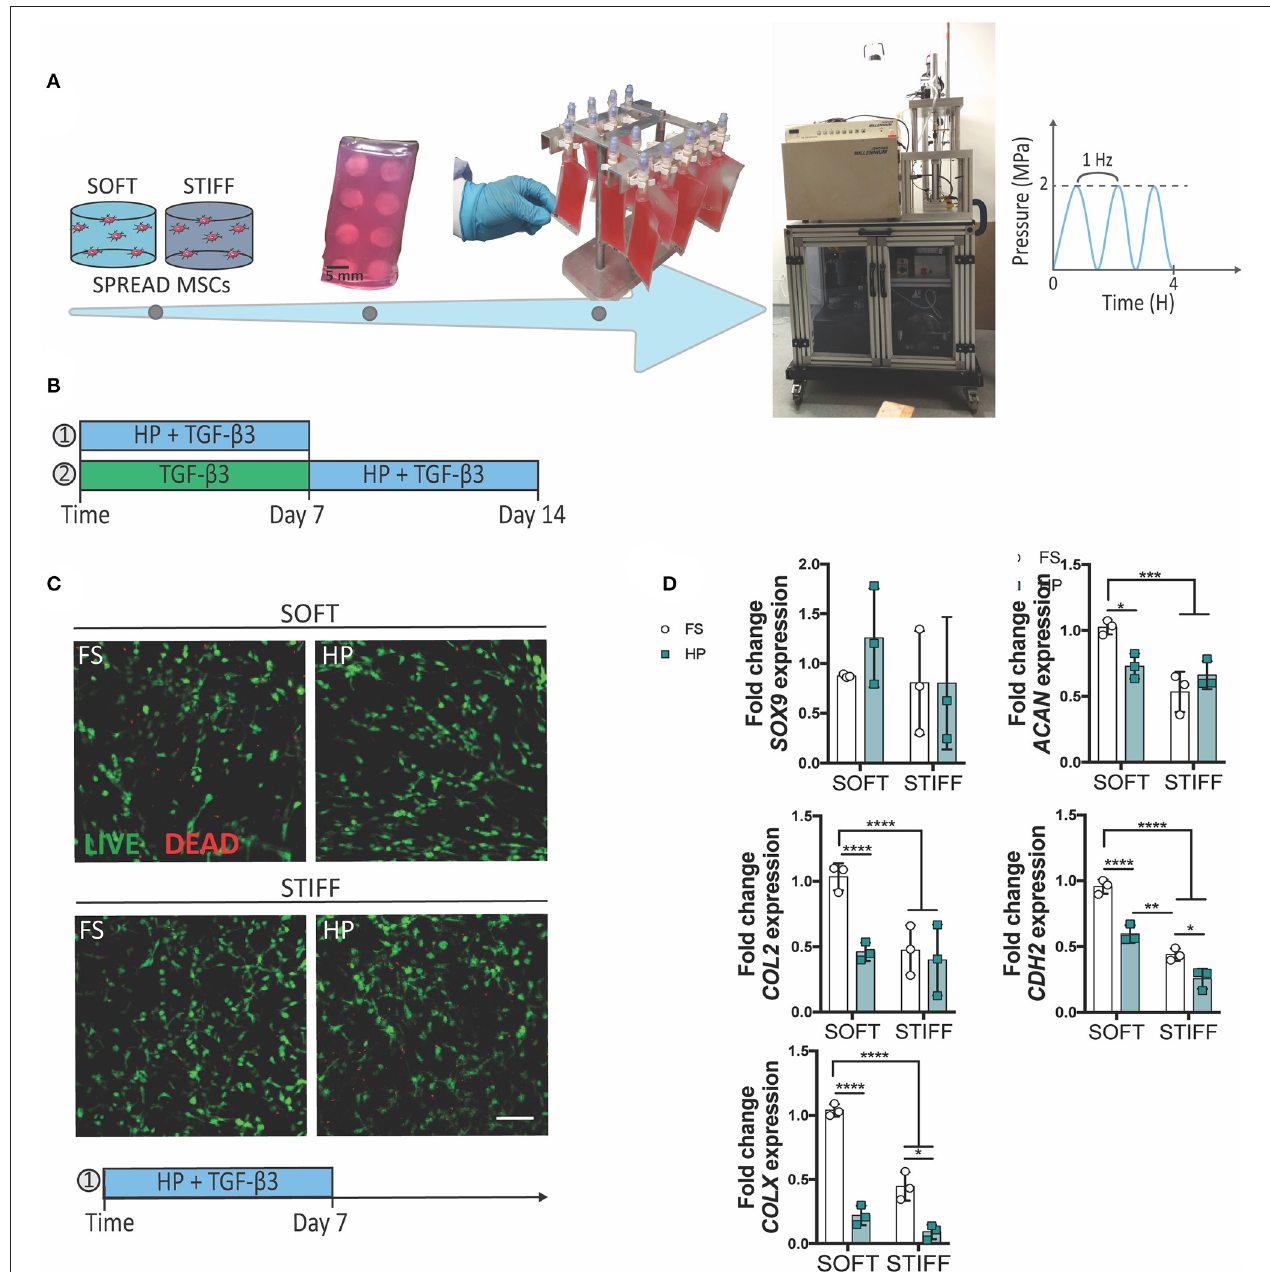
FIGURE 1 | The inhibitory effect of early HP stimulation on chondrogenesis of MSCs. Schematics depicting (A) the sample preparation procedure and (B) the experimental design. (C) Qualitative analysis of MSC viability after 7 days of dynamic culture. Live cells stained in green, dead cells in red. Scale bar 100 µ m. (D) Chondrogenic gene expression levels relative to the SOFT FS group. MSCs were cultured for 7 days in presence of chondrogenic factors and HP stimulation. FS, Free Swelling group; HP, Hydrostatic Pressure group. * p < 0.05, ** p < 0.01, *** p < 0.001, **** p < 0.0001.